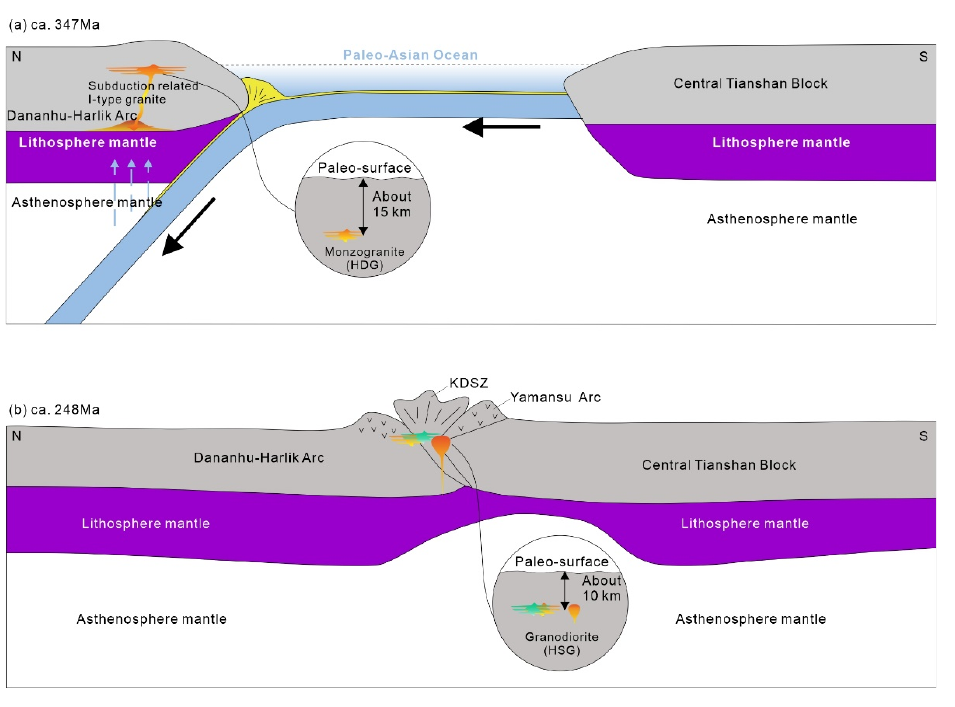
Figure 12. Schematic diagram of the crustal uplift during Early Carboniferous to Early Triassic.